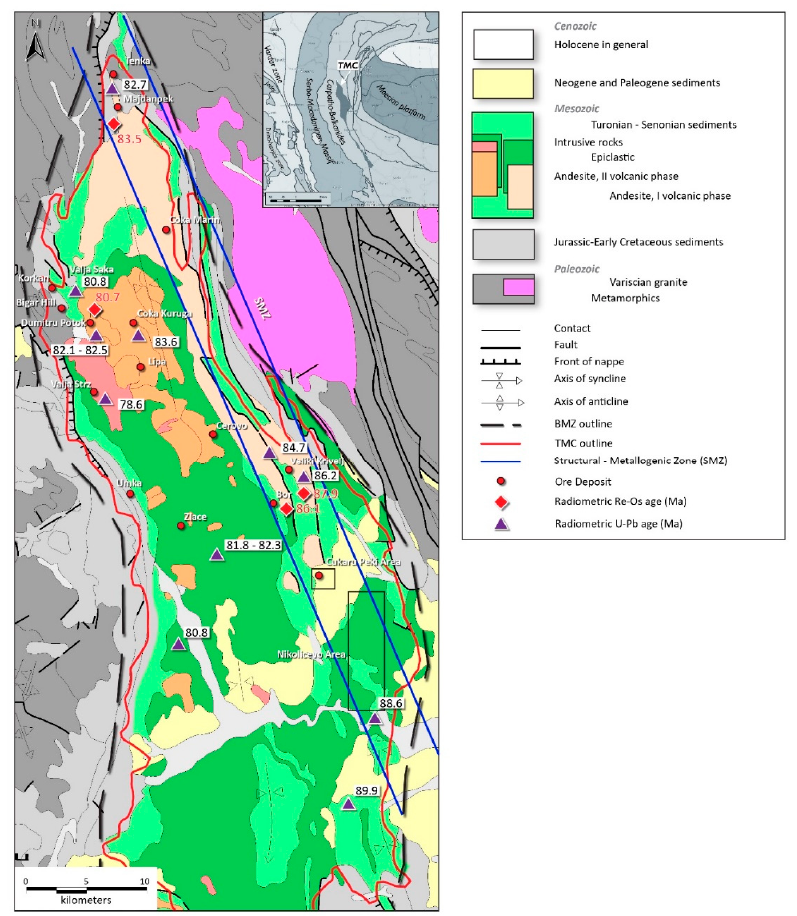
Figure 1. A geological-metallogenetic map of the Timok Magmatic Complex (TMK) and the Bor Metallogenetic Zone (BMZ); the numbers are literature U-Pb and Re-Os age data [7,10,11,13,32]; the inset shows the regional geotectonic position; note that the legend is organized in the form of a simplified geological column.